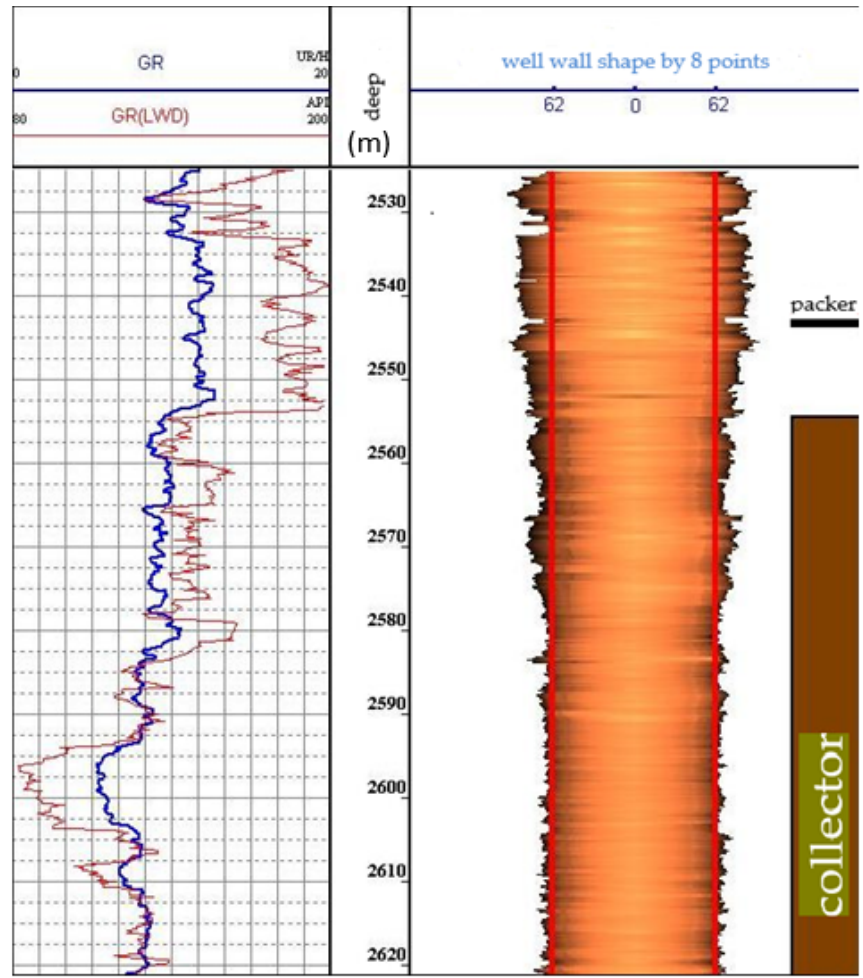
Figure 2. Well survey using acoustic